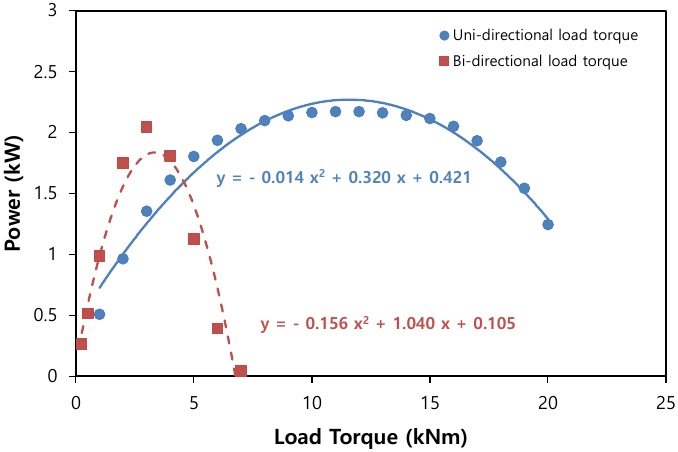
Figure 8. Time series of pitch moment at H = 0.75 m and T = 4.75 s. The extracted powers in response to increasing bi- and uni-directional PTO load torque at H = 0.75 m and T = 4.75 s were compared, as shown in Figure 9. The extracted powers were averaged over three times the wave periods. The optimized uni-directional PTO load torque (12 kNm) was more than the optimized bi-directional PTO load torque (3 kNm). The extracted power curve of second-order polynomial at uni-directional PTO load torque is much milder than at bi-direction. This means that the uni-directional PTO load torque is relatively insensitive to changes in extracted power with respect to changes in the PTO load torque. This characteristic is considered suitable for the hydraulic PTO system in the real sea test, which ensures a broad effective PTO range.